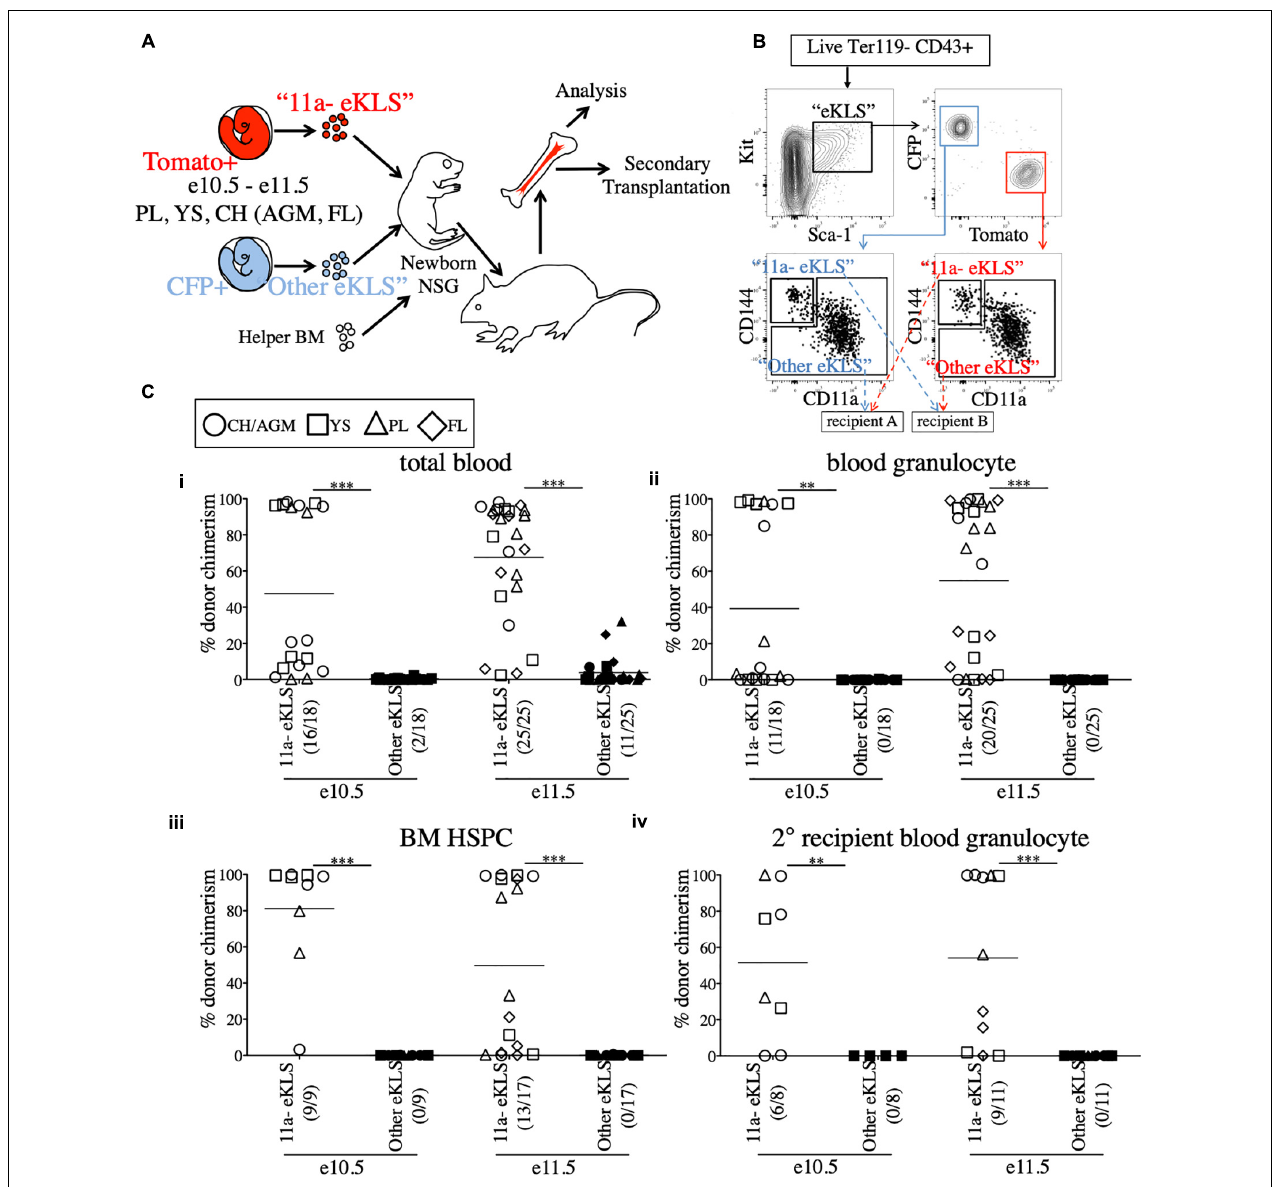
FIGURE 2 | All functional pre-HSCs are contained within the CD11a- fraction of e10.5 and e11.5 embryonic progenitors. (A) Schematic representation of the competitive transplant system. Sorted Tomato-expressing “11a-eKLS” and CFP-expressing “Other eKLS” cells (and vice versa) are combined and mixed with non-fluorescent CD45.2+ adult helper BM for transplantation into newborn NSG recipients. (B) Representative sorting strategy for the competitive transplantation of 11a- eKLS and Other eKLS populations. Embryonic progenitors are defined as live, Ter119- CD43+ Kit+ Sca1+ cells. Tomato+ and CFP+ progenitors are then gated, and CD11a- CD144+ (“11a- eKLS”) and everything else (“Other eKLS”) are sorted. Opposing populations of different colors are mixed post-sort and transplanted into the same recipient. Representative plots and gates for each tissue and timepoint can be found in Supplementary Figure 3 . (C) Donor chimerism from 11a- eKLS and Other eKLS populations in primary and secondary recipients. Percent donor chimerism of total blood (i) , blood granulocyte (ii) , BM HSPC (iii) in primary recipients and blood granulocyte chimerism in secondary recipients (iv) from 11a- eKLS (white symbols) and Other eKLS (black symbols). Numbers in parenthesis indicate successful chimerism/total recipients engrafted with embryonic cells of any source. Blood analysis was done after at least 12 weeks post primary transplant and after at least 6 weeks post secondary transplant. 1% is set as a threshold to define successful chimerism. CH/AGM (circle), YS (squares), PL (triangles), and FL (diamond) are shown. For a tissue-specific analysis of both timepoints, refer to Supplementary Figure 4